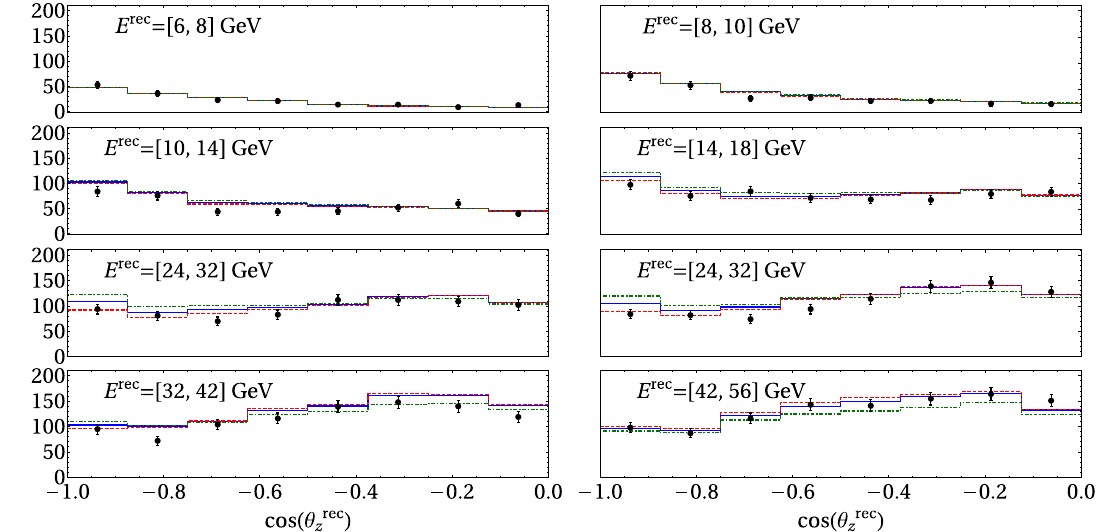
2 . 3 × 10 − 23 GeV(solidblueline), γ 21 = γ 31 = 10 − 22 GeV(dot-dashed green line) and without decoherence (dashed red line). The observed data points [44] are represented by the black dots, and the error bars indicate the statistical uncertainties for each